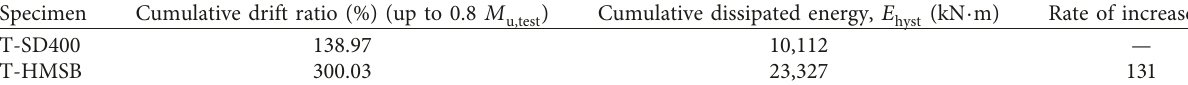
Table 4: Summary of cumulative dissipated energy calculation results.